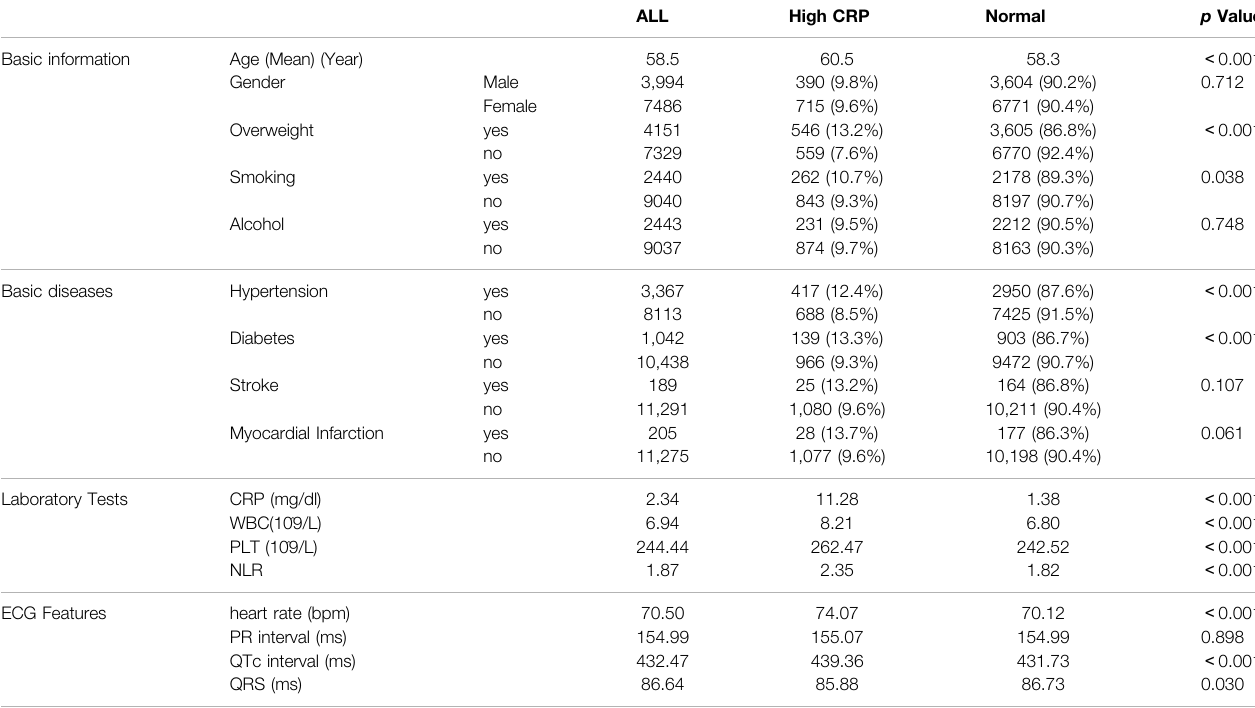
TABLE 1 | Clinical Characteristics of Patients.